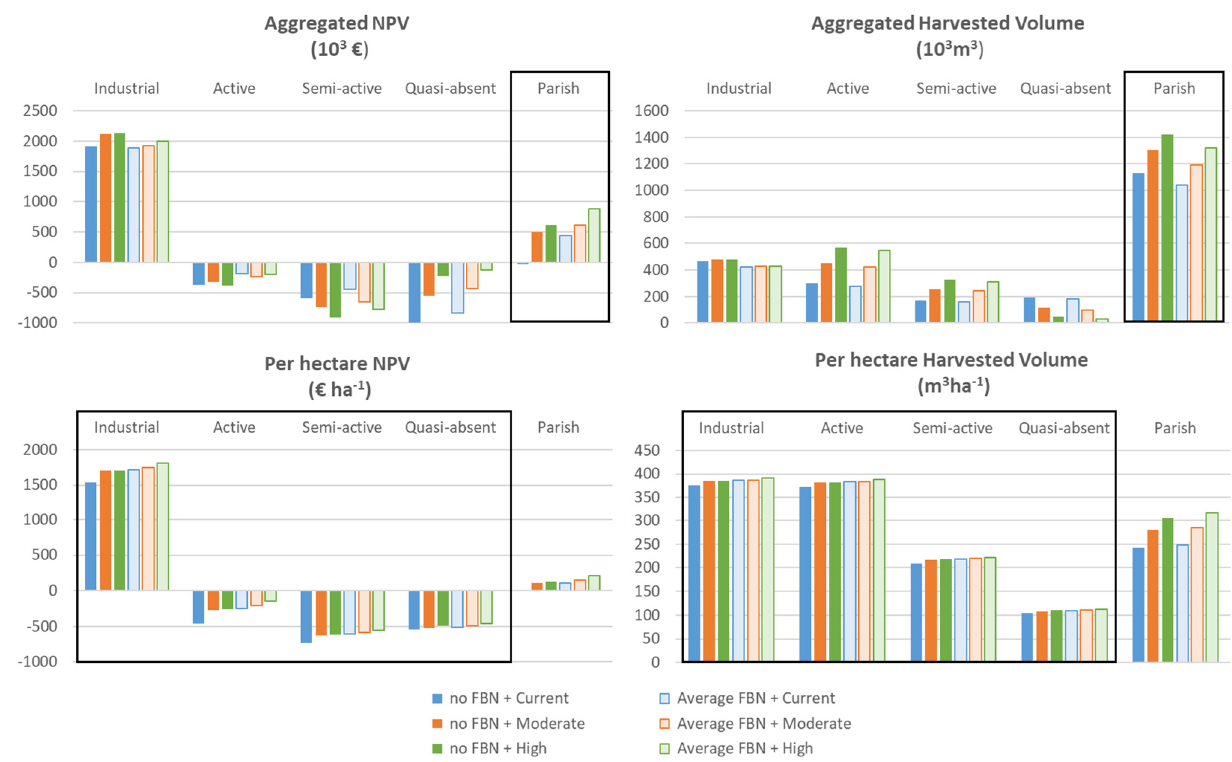
Figure 6. Comparison of aggregated and per hectare NPV and harvested volume for no FBN and the average of the FBN priorities for the three management levels by owner type and at parish level using.